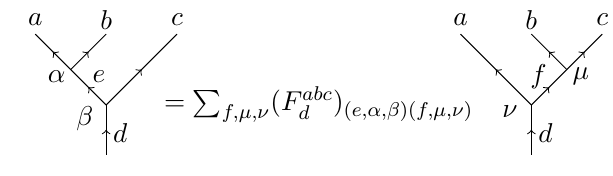
Figure 1 . Graphical representation of fusion and splitting.